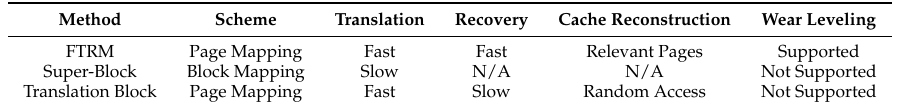
Table 1. A qualitative comparison on existing alternative approaches with our proposed fault tolerant power-failure recovery mechanism ( FTRM ) approach. Method Scheme Translation Recovery Cache Reconstruction Wear Leveling FTRM Page Mapping Fast Fast Relevant Pages Supported Super-Block Block Mapping N/A Not Supported Translation Block Page Mapping Fast Slow Random Access Not